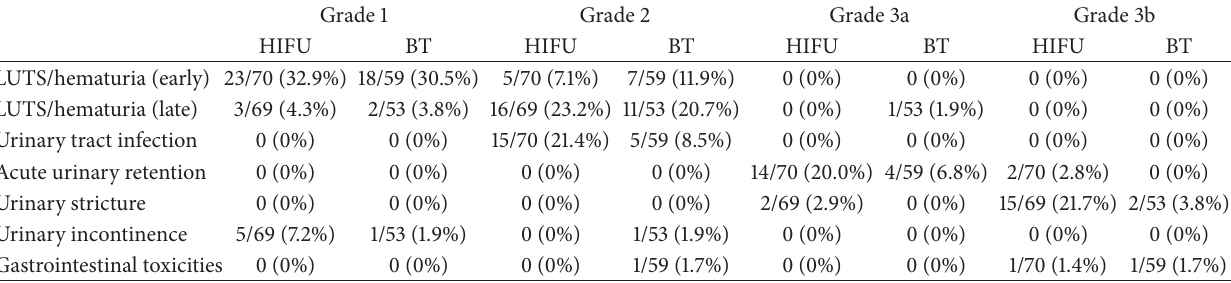
Table 5: Comparison of overall complications by grade of severity between the two